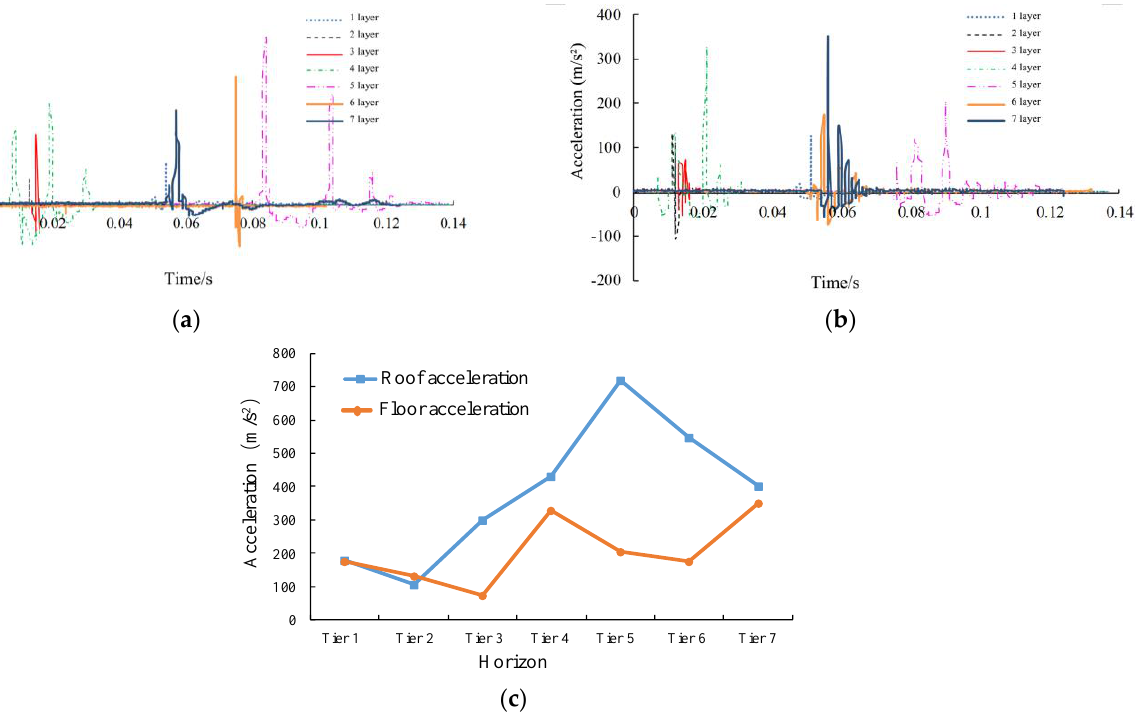
Figure 17. Acceleration response characteristics of each layer when the pendulum height is 0.3 m. ( a ) Acceleration at the roof of surrounding rock; ( b ) Acceleration at the floor of the roadway; ( c ) Peak acceleration at each level.